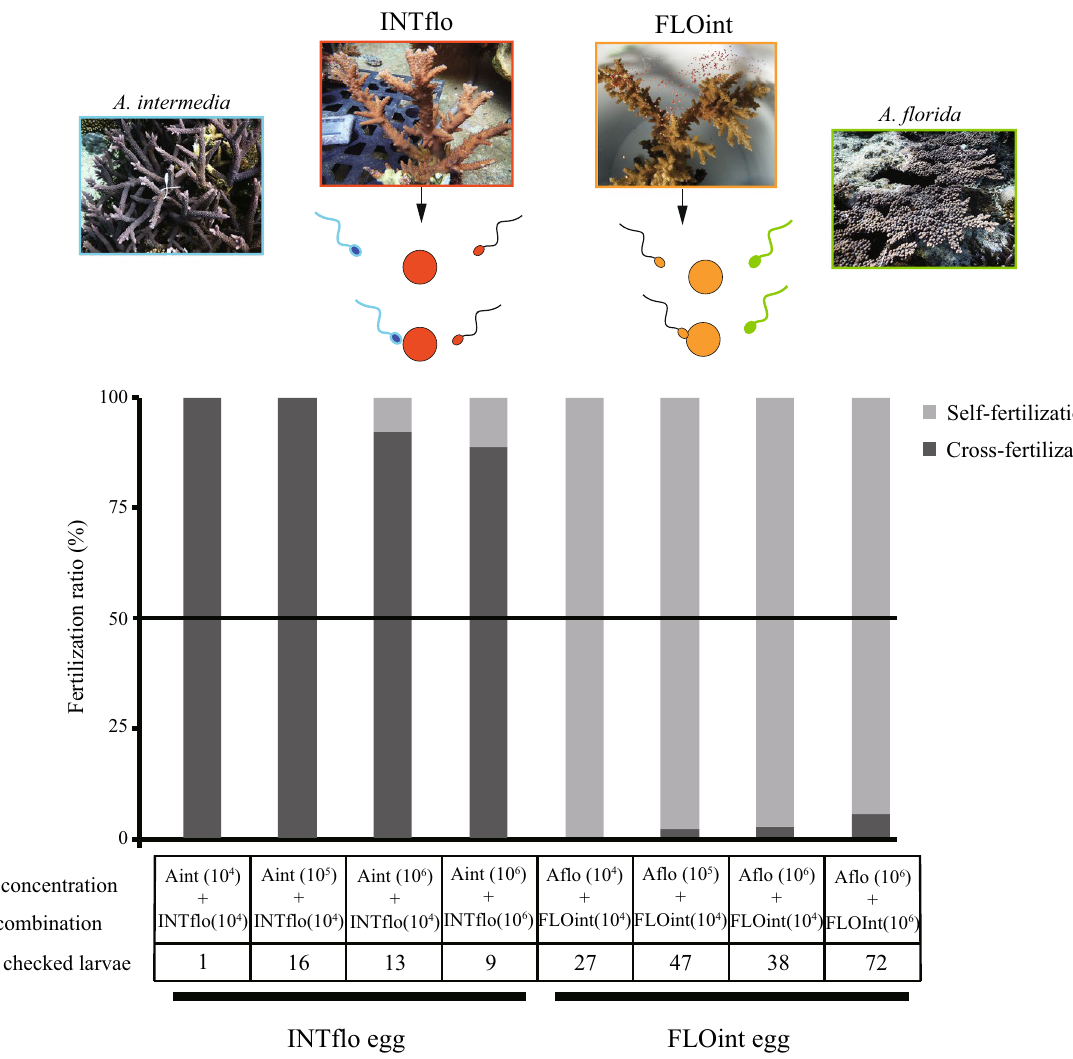
Figure 1. Backcrossing or self-fertilization of hybrid eggs. Sperm choice experiments using hybrid eggs are shown. INTflo and FLOint eggs showed different features: INTflo eggs backcrossed with the sperm of the mother species, whereas FLOint eggs self-fertilized as reported in Isomura et al. 21 . Light grey bars indicate the fertilization ratio of hybrid sperm (self-fertilization), and the dark grey bars indicate the sperm of the parental species. Microsatellites were checked using electrophoresis or Microsatellite Analysis v1.0 (Applied Biosystems) software (https:// www. therm ofish er. com/ order/ catal og/ produ ct/ 43818